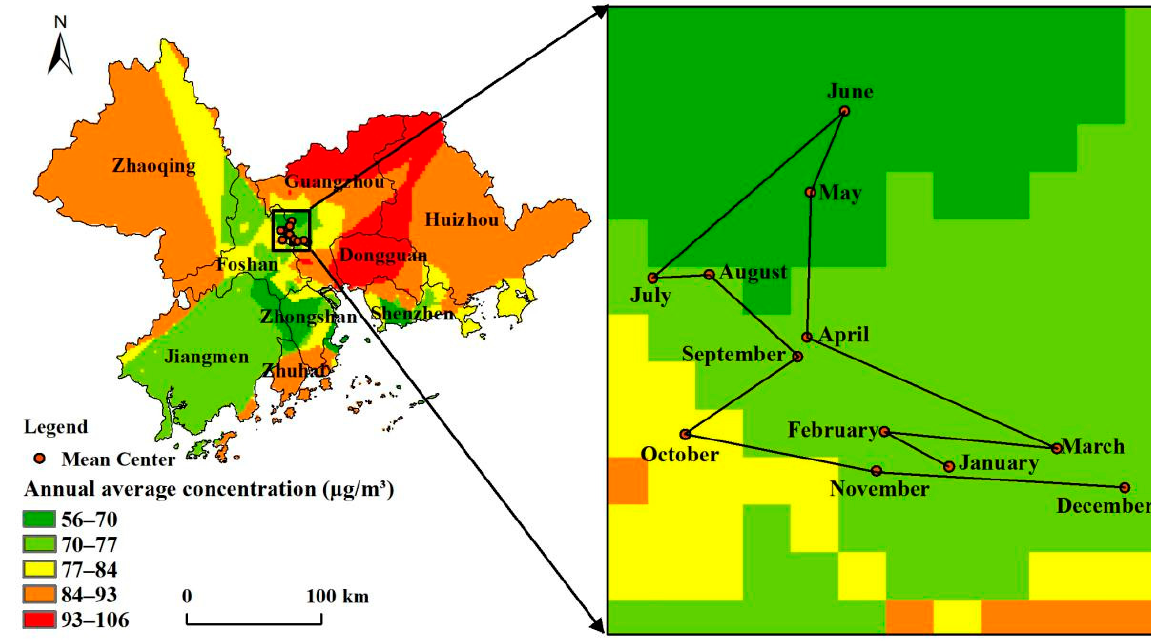
Figure 2. Spatial distribution of annual average ozone concentration and average center variation in the Pearl River Delta Metropolitan